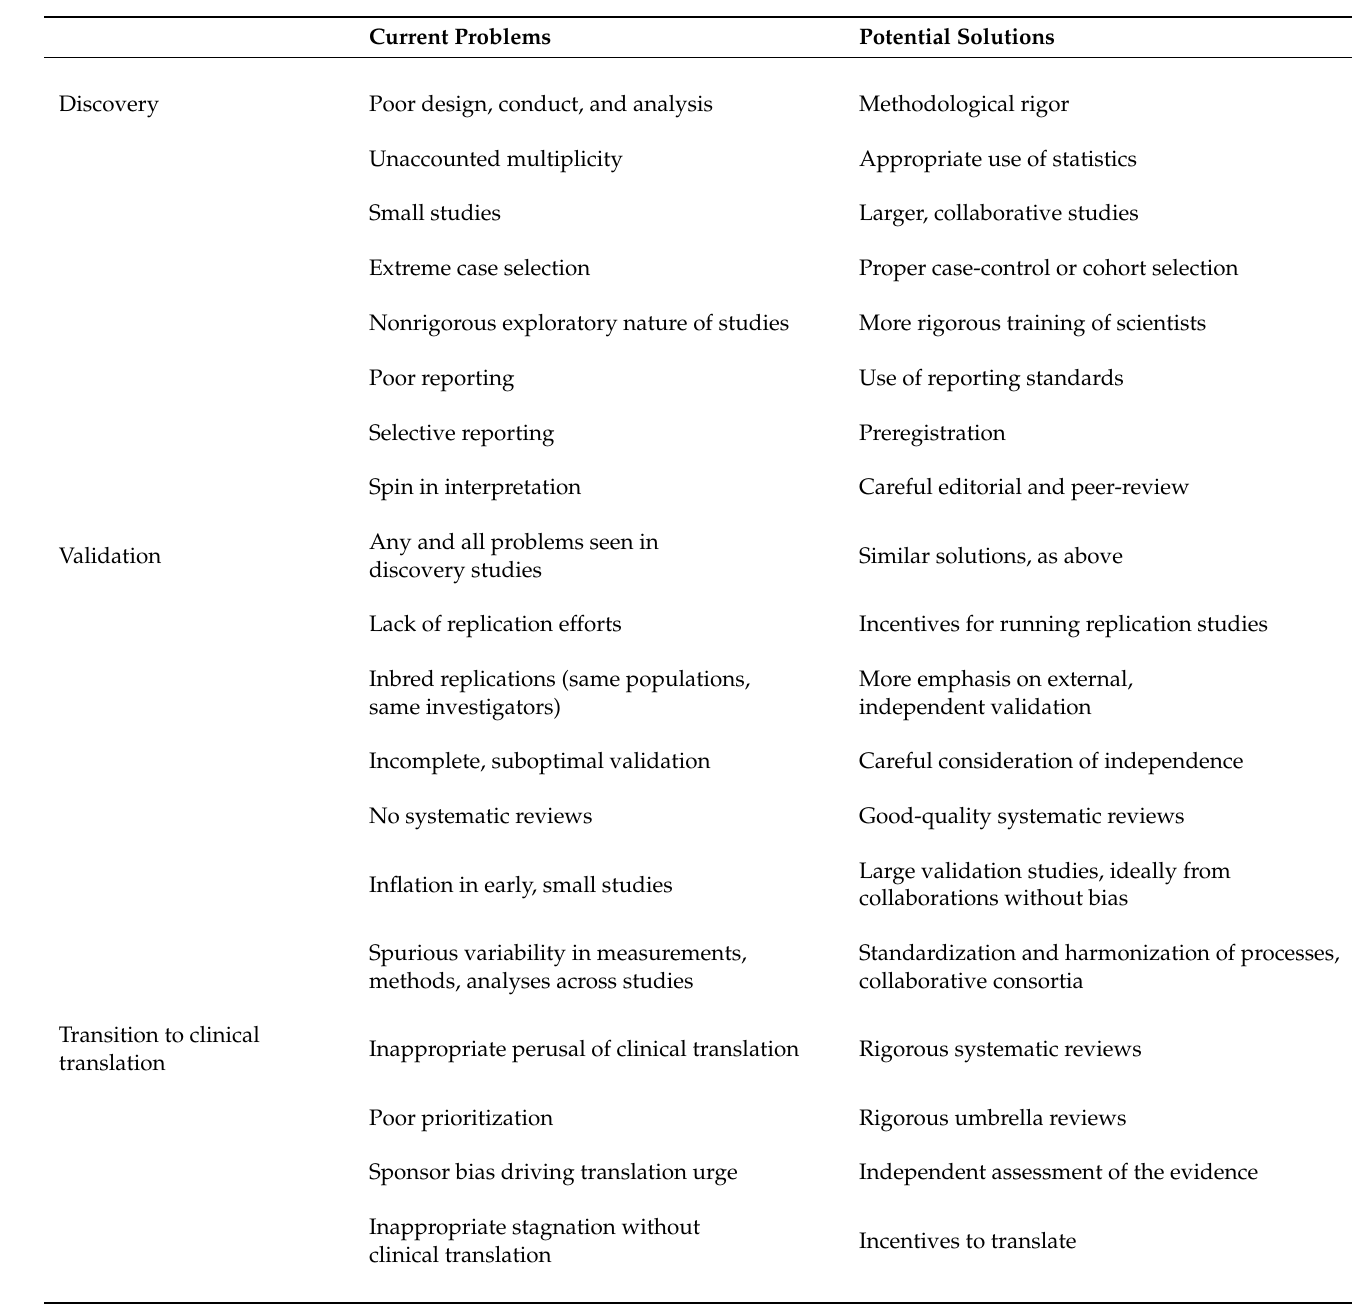
Table 1. Challenges and sources of potential failures in conventional targeted biomarker discovery efforts. This table lists current challenges in different phases of biomarker discovery. Parallels, at each phase of discovery, validation, translation, evaluation, and implementation can be drawn to be used as guidelines for potential pitfalls of ambient mass spectrometry profiling. Reproduced with permission